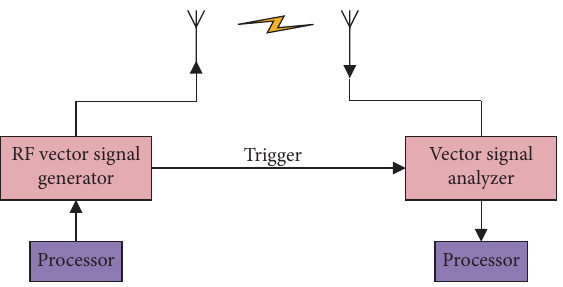
Figure 2: Transmitting and receiving system. Table 1: Antenna